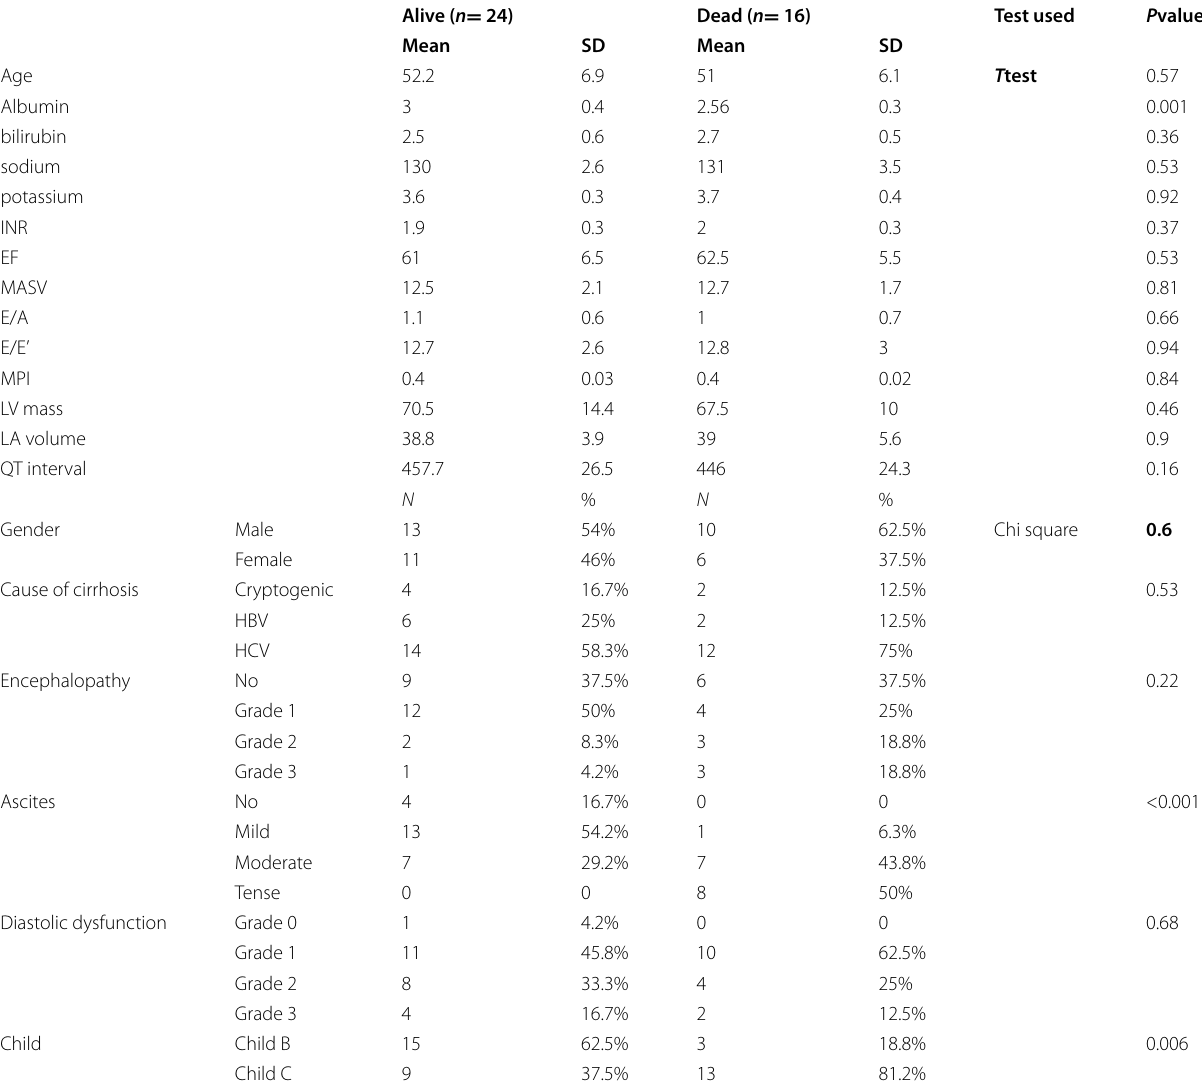
Table 6 Comparison of demographic, laboratory, echocardiographic data, and QTc interval in patients according to whether they were alive or dead at the beginning of a 3-month follow-up period